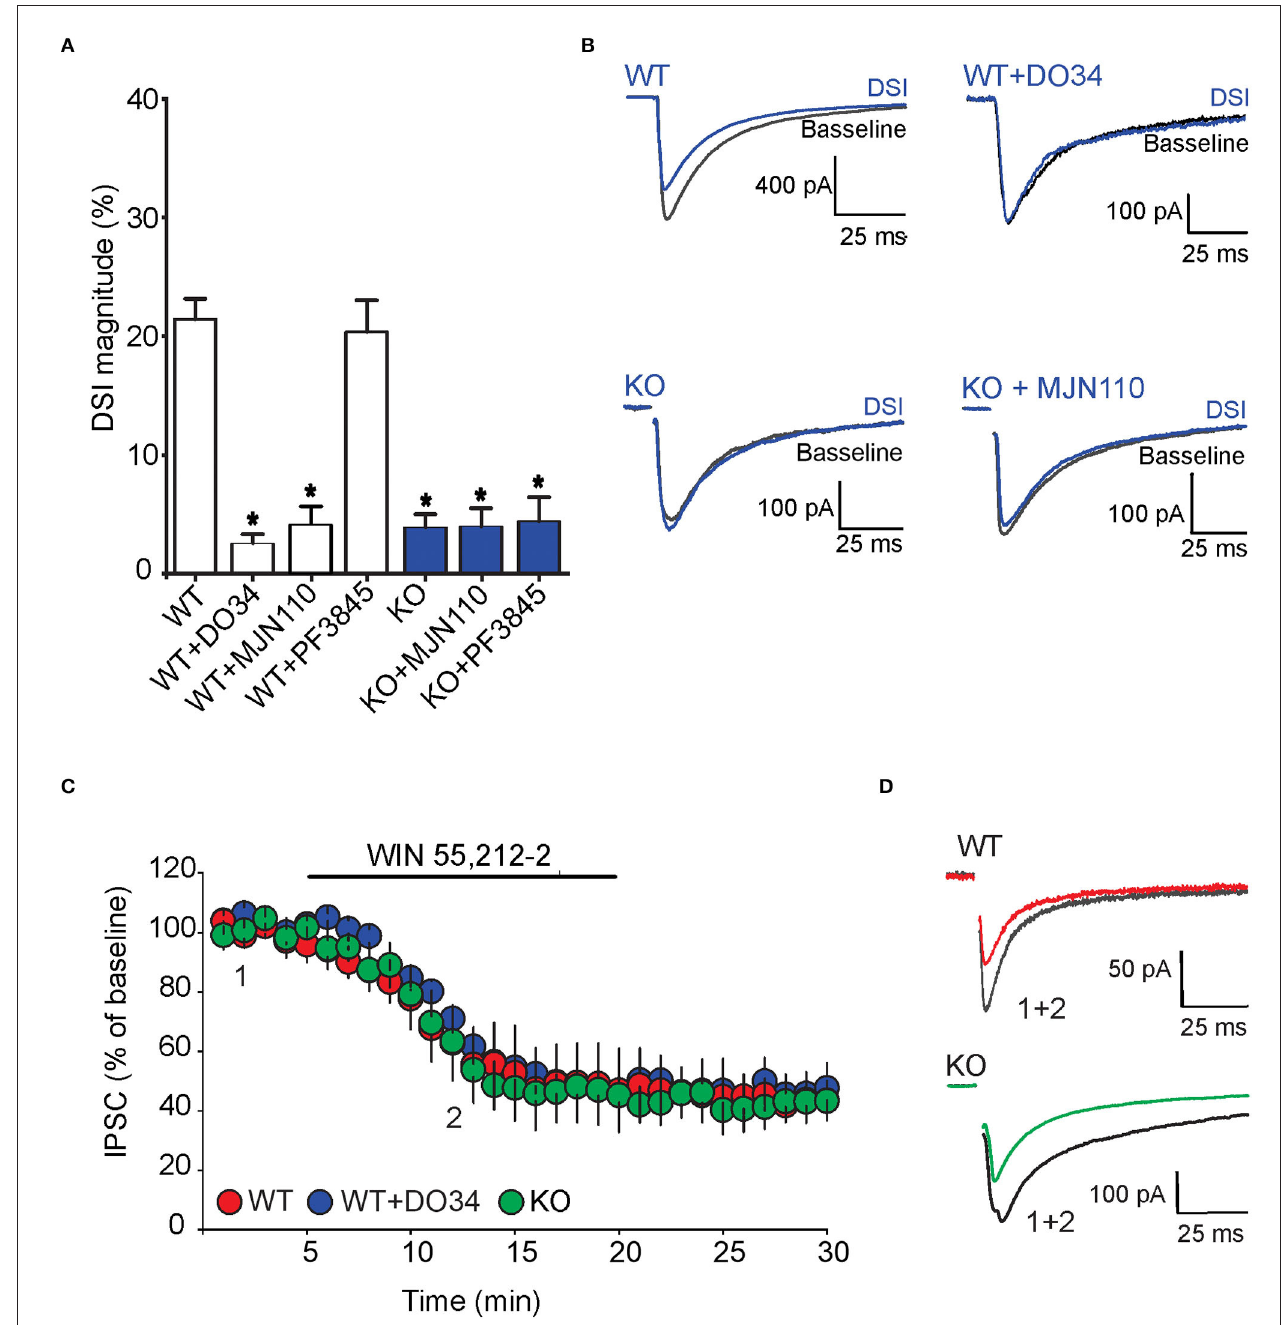
FIGURE 7 | FABP5 deletion blunts 2-AG mediated DSI without altering CB1R function in striatal MSNs. (A) DSI magnitude obtained in striatal slices from WT (white bars) and FABP5 KO mice (blue bars), incubated with vehicle (WT: 21.43 ± 1.70%, n = 12 cells from 10 mice; KO: 3.90 ± 1.08%, n = 12 cells from 10 mice), DO34 (1 µ M) (WT + DO34: 2.53 ± 0.75%, n = 8 cells from 6 mice, p < 0.05 vs. WT), MJN110 (10 µ m) (WT + MJN110: 4.14 ± 1.45%, n = 7 cells from 6 mice, p < 0.05 vs. WT), or PF3845 (3 µ M) (WT + PF3845: 20.35 ± 2.66%, n = 7 cells from 6 mice, p > 0.05 vs. WT, * p < 0.05 vs WT). (B) Sample eIPSC traces before and during DSI in WT, WT + D034, FABP5 KO, FABP5 KO + MJN110. (C) The depression of eIPSCs induced by the CB1R agonist WIN55,212-2 (10 µ M) in striatal slices from WT (red) (WT: 47.81 ± 11.80% of baseline, n = 9 cells from 5 mice, t 8 = 4.28, p < 0.01, vs. baseline), WT + DO34 (blue) (WT + DO34: 49.75 ± 6.06% baseline, n = 8 cells from 5 mice, t 7 = 9.84, p < 0.001, vs. baseline), or FABP5 KO mice (green) (FABP5 KO: 45.18 ± 10.61% baseline, n = 8 cells from 5 mice, t 7 = 5.11, p < 0.01, vs. baseline). Note that FABP5 deletion or inhibition of DAGL did not alter CB1R function. (D) Sample eIPSC traces taken before (1) and during (2) WIN55,212-2 application in WT and FABP5 KO striatal